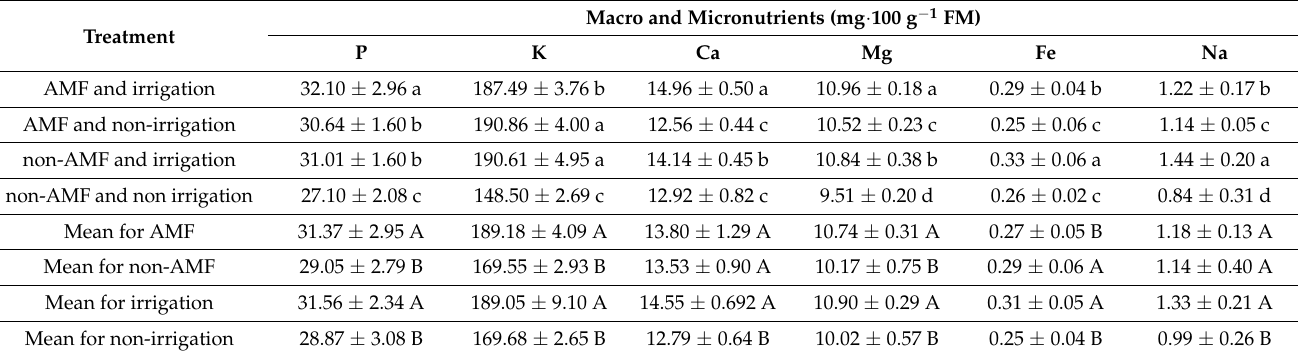
Table 4. Mineral composition of sweet pepper grown with or without mycorrhizal inoculation and irrigation (mean for